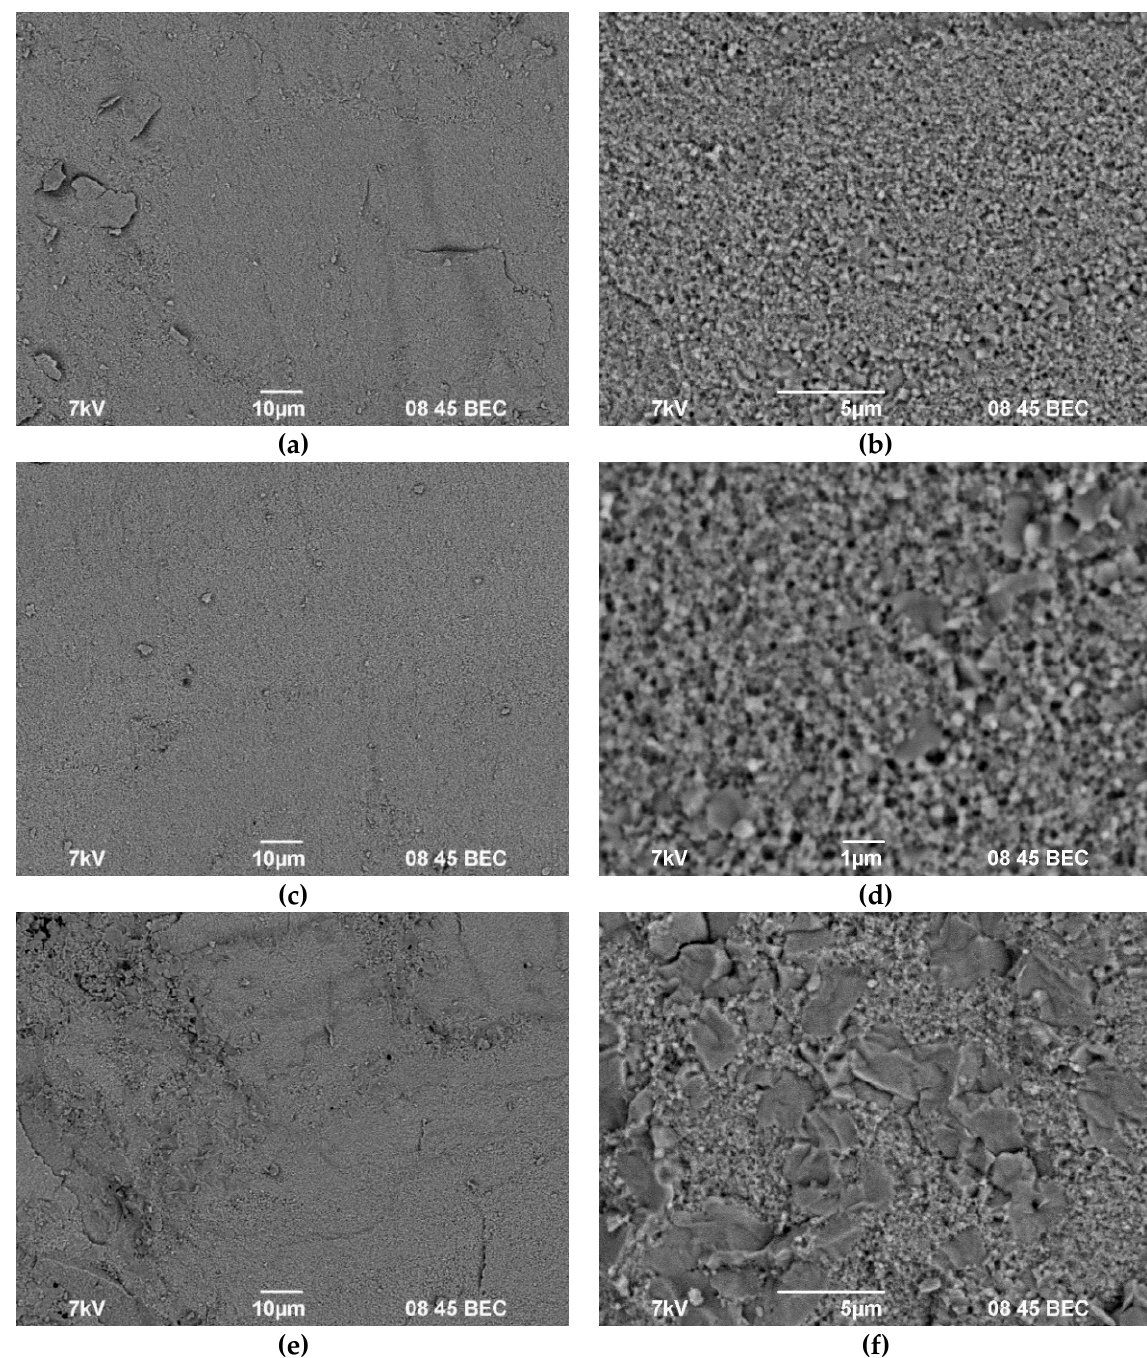
Figure 8. SEM images of macrostructure ( a , c , e ) and microstructure ( b , d , f ) of Na 1.2 Zr 1.9 Co 0.1 (PO 4 ) 3